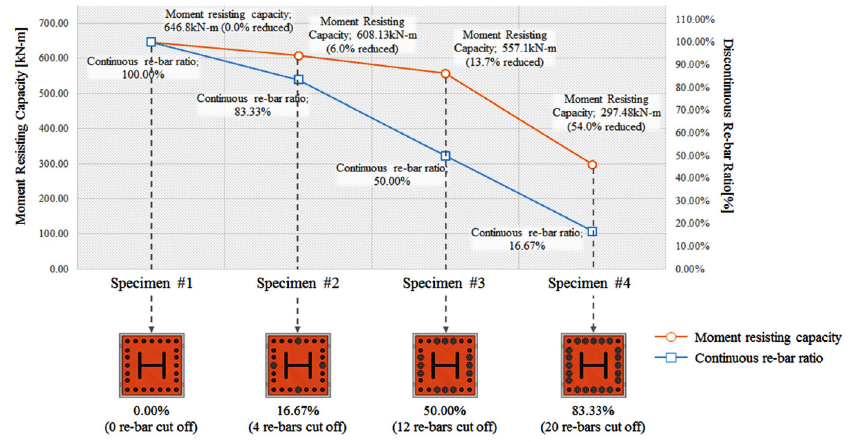
Fig. 18. Maximum moment resisting capacity versus number of continuous reinforcing bars